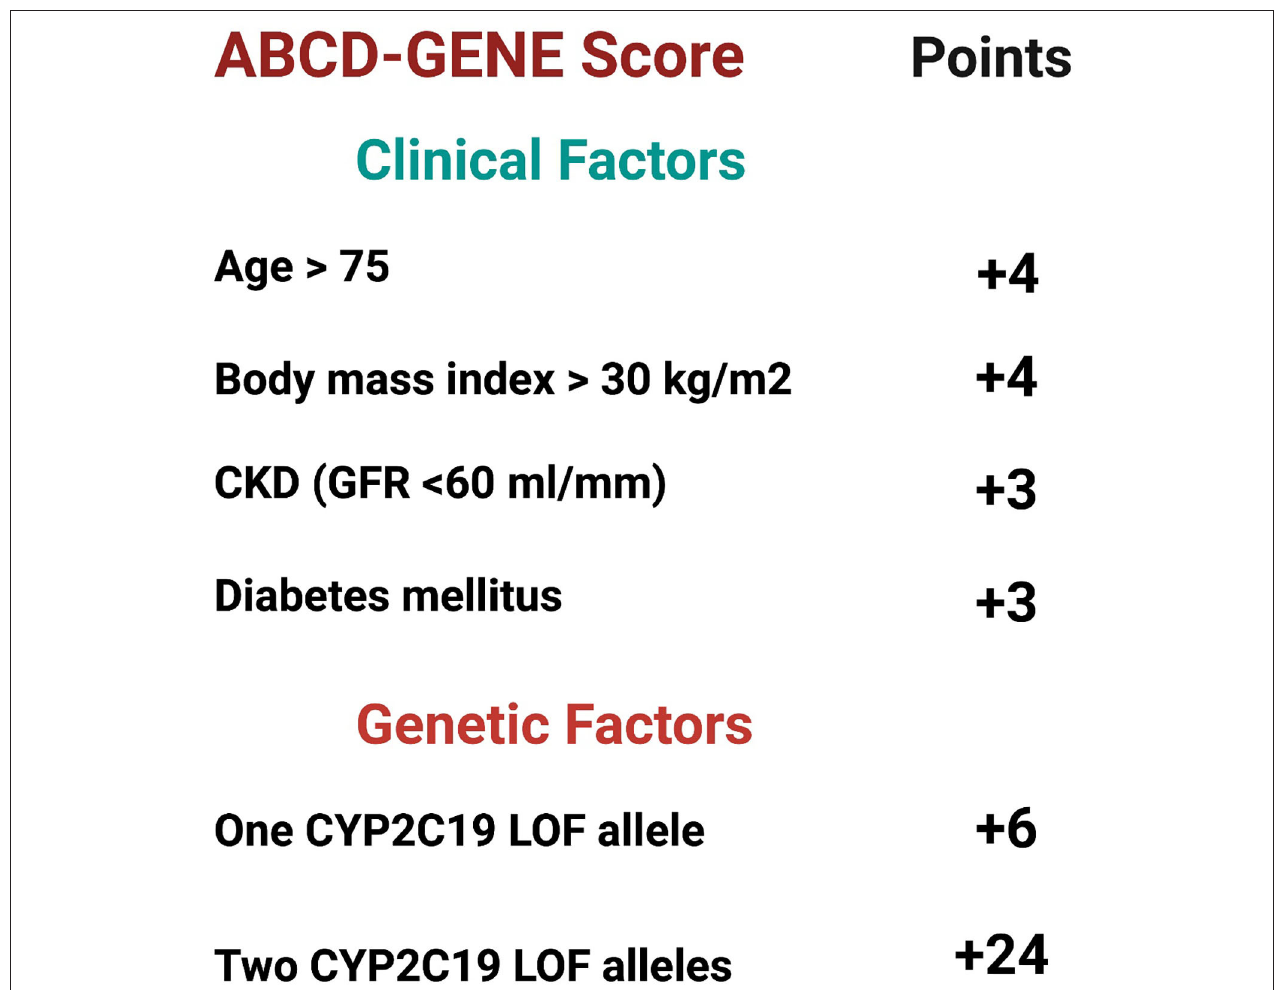
FIGURE 4 | ABCD-Gene scoring system. The ABCD-GENE scoring system was developed to predict patients who are on P2Y12 inhibitors and at risk of high platelet reactivity (HPR). The scoring system was internally and externally validated. Patients with ABCD-Gene score ≥ 10 are at higher risk of all-cause death and major cardiovascular adverse events (MACE) at 1-year compared to those with a score < 10. Created with BioRender.com (99). CKD, chronic kidney disease; CYP2C19, cytochrome P450 2C19; GFR, glomerular filtration rate; LOF, loss of